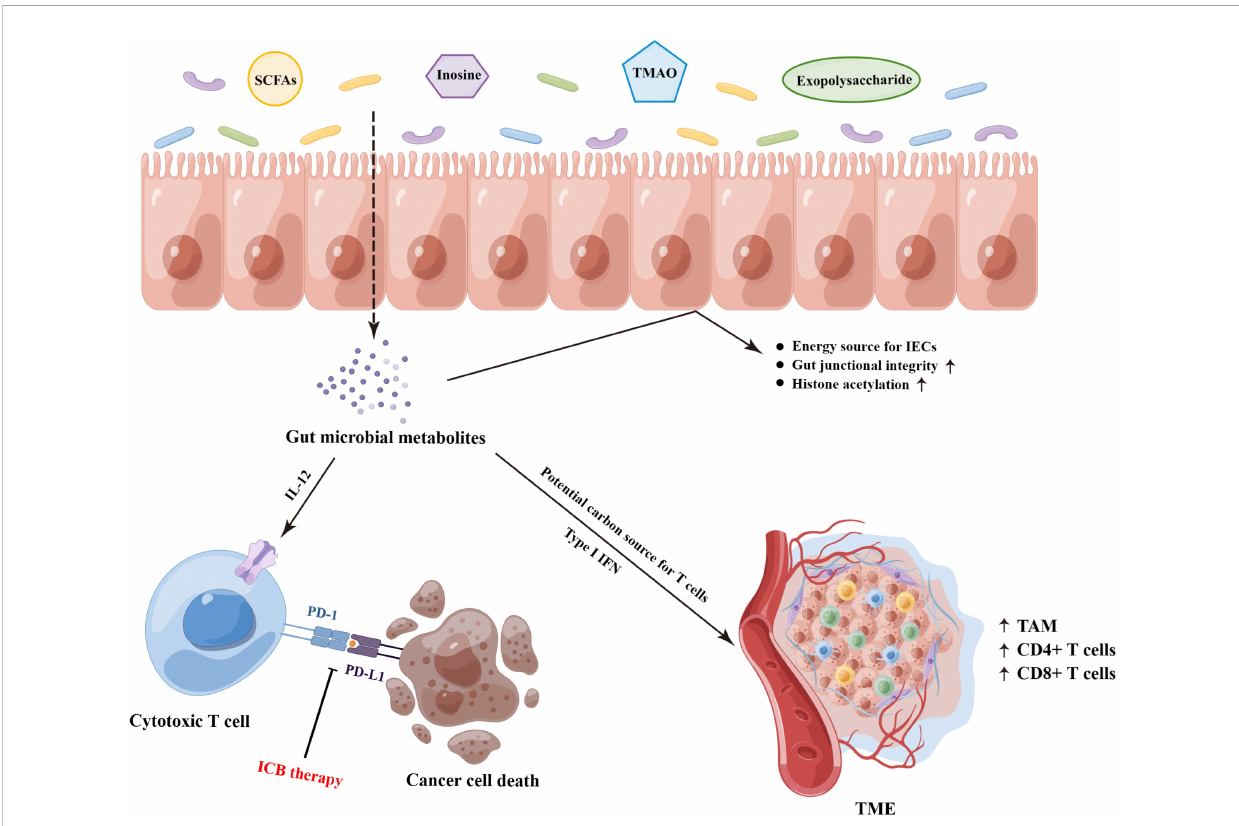
FIGURE 2 The underlying molecular mechanisms on the gut microbiota-derived metabolites that mediated the responses of ICB therapy. SCFAs, short − chain fatty acids; TMAO, trimethylamine N-oxide; IECs, intestinal epithelial cells; ICB, immune checkpoint blockade; TAM, tumor-associated macrophage; TME, tumor microenvironment. (By